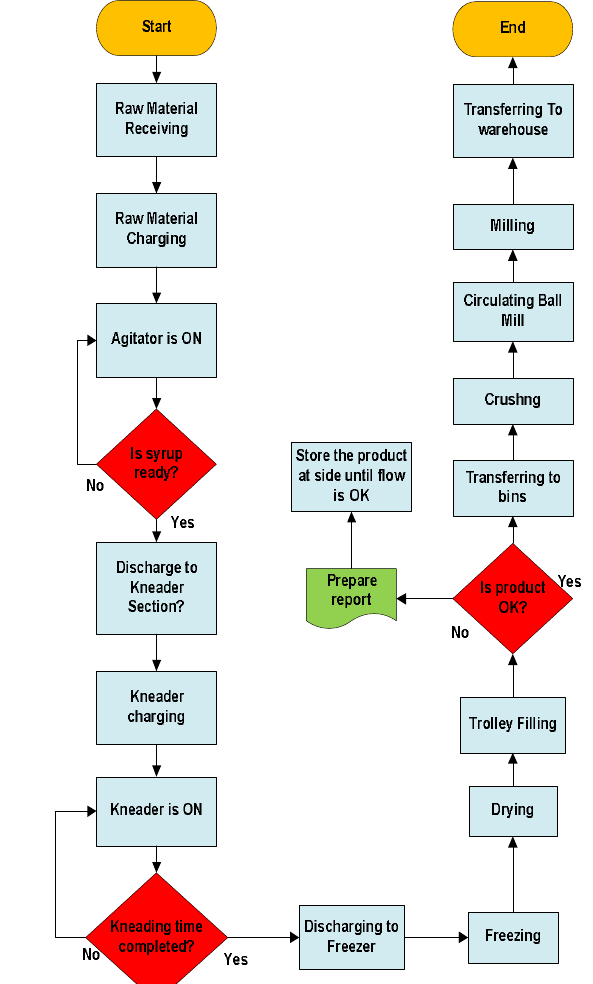
Fig. 2: Complete process flow of molding compound powder